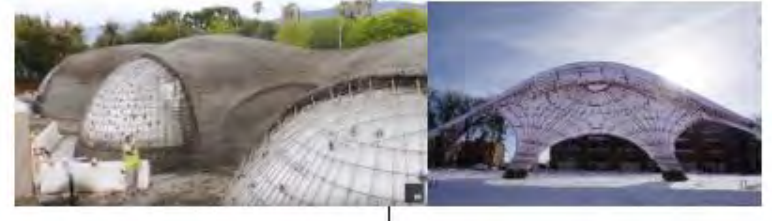
Figure 1. (a) Bini Shells withinflatables covered by a metal mesh as lost reinforcement to be sprayedmanually with shotcrete. 1(b) Spray ice on fabric formwork and active bendingmetallic elements. “Zero bending moment” Lancelot Coar Winnipeg,